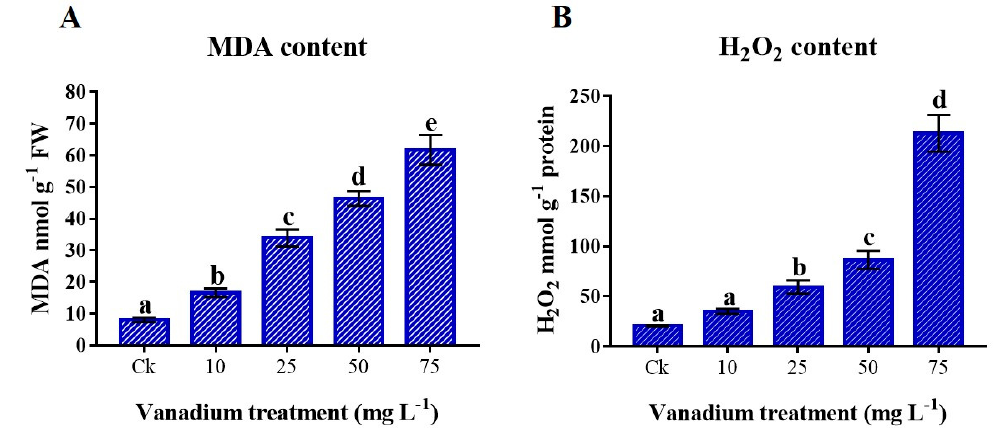
Figure 5. The influence of various V treatments on the production of reactive oxygen species (ROS) and lipid peroxidation in the leaves of sweet potato. ( A ) Malondialdehyde (MDA) and ( B ) hydrogen peroxide (H 2 O 2 ) content. Duncan’s test specifies a significant difference ( p < 0.05) between the means of the five treatments indicated by different alphabets.